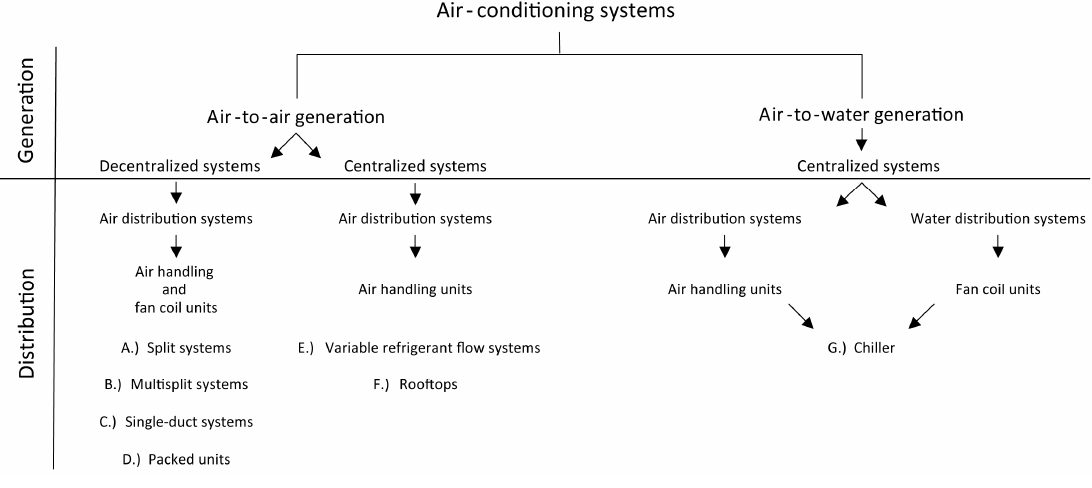
Figure 1. Breakdown of different air-conditioning (AC) typologies [12–18,33–38].